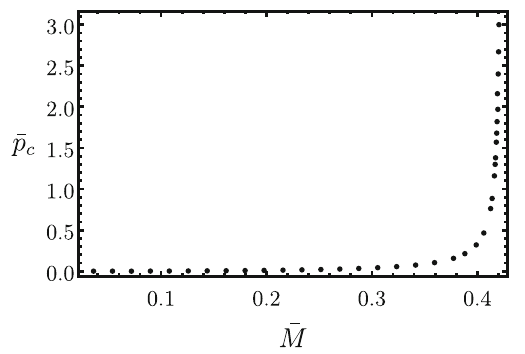
Fig. 16 The plot shows the dependence of ¯ M with the central pressure in GR with the exponential profile ( ¯ ρ 0 = 0 . 10). The maximum value of ¯ M is approx. 0.42, and corresponds to ¯ p c ≈ 3